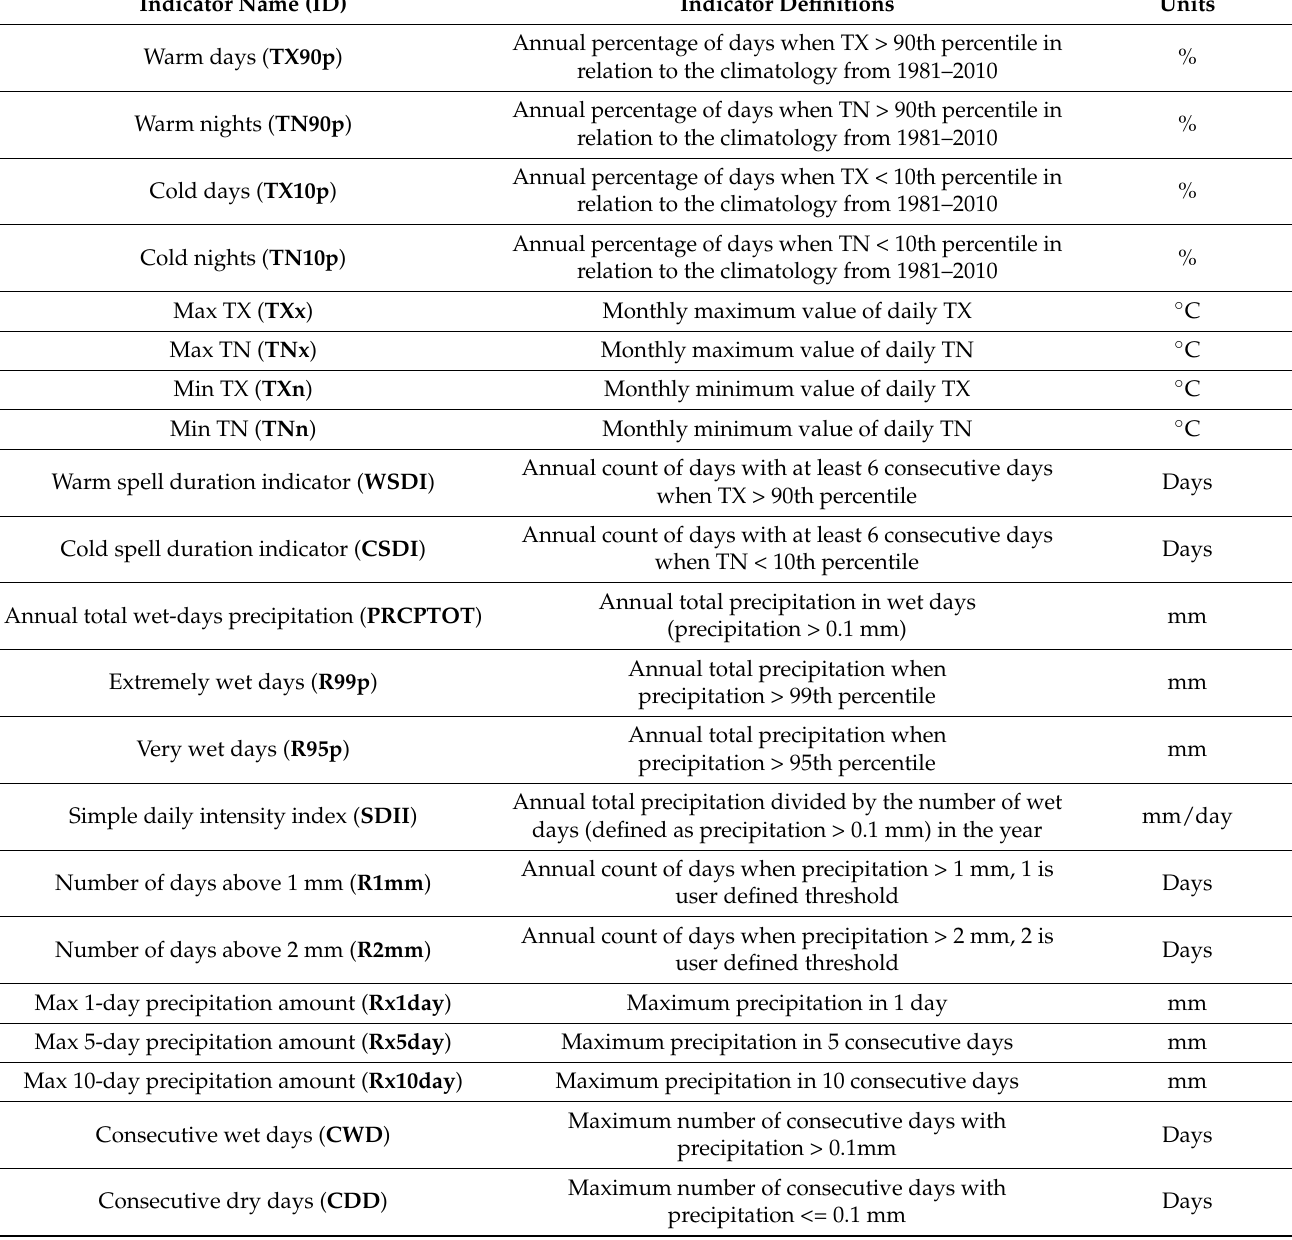
Table 2. Extreme temperature and precipitation indices selected for this